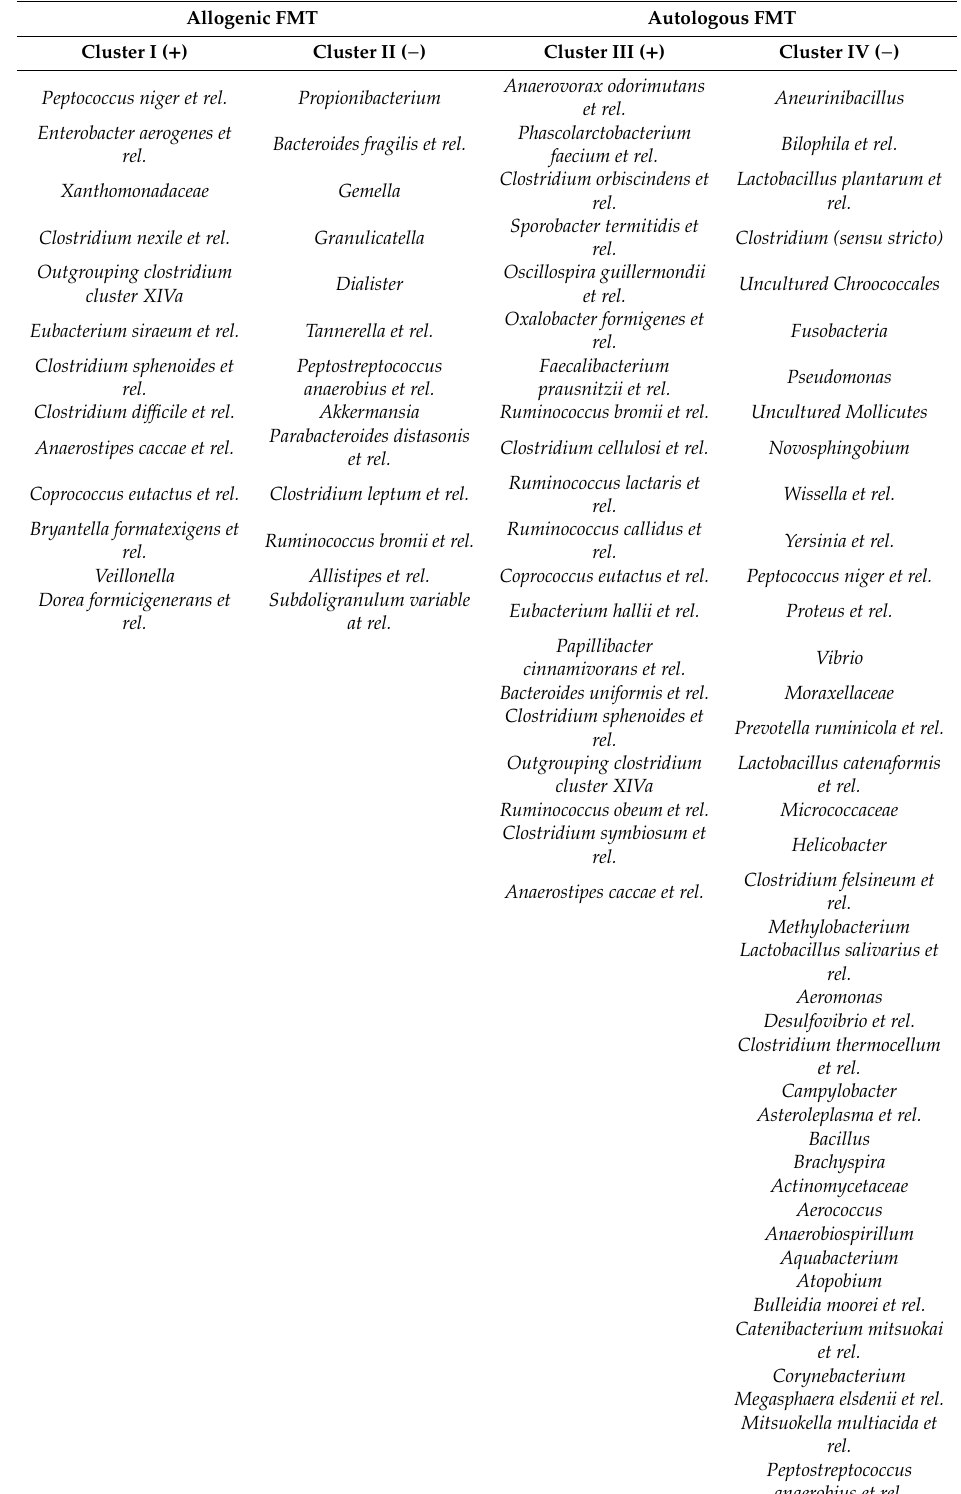
Table 2. Bacterial genera positively ( + ) or negatively ( − ) correlating to immune-related gene sets a ff ected by